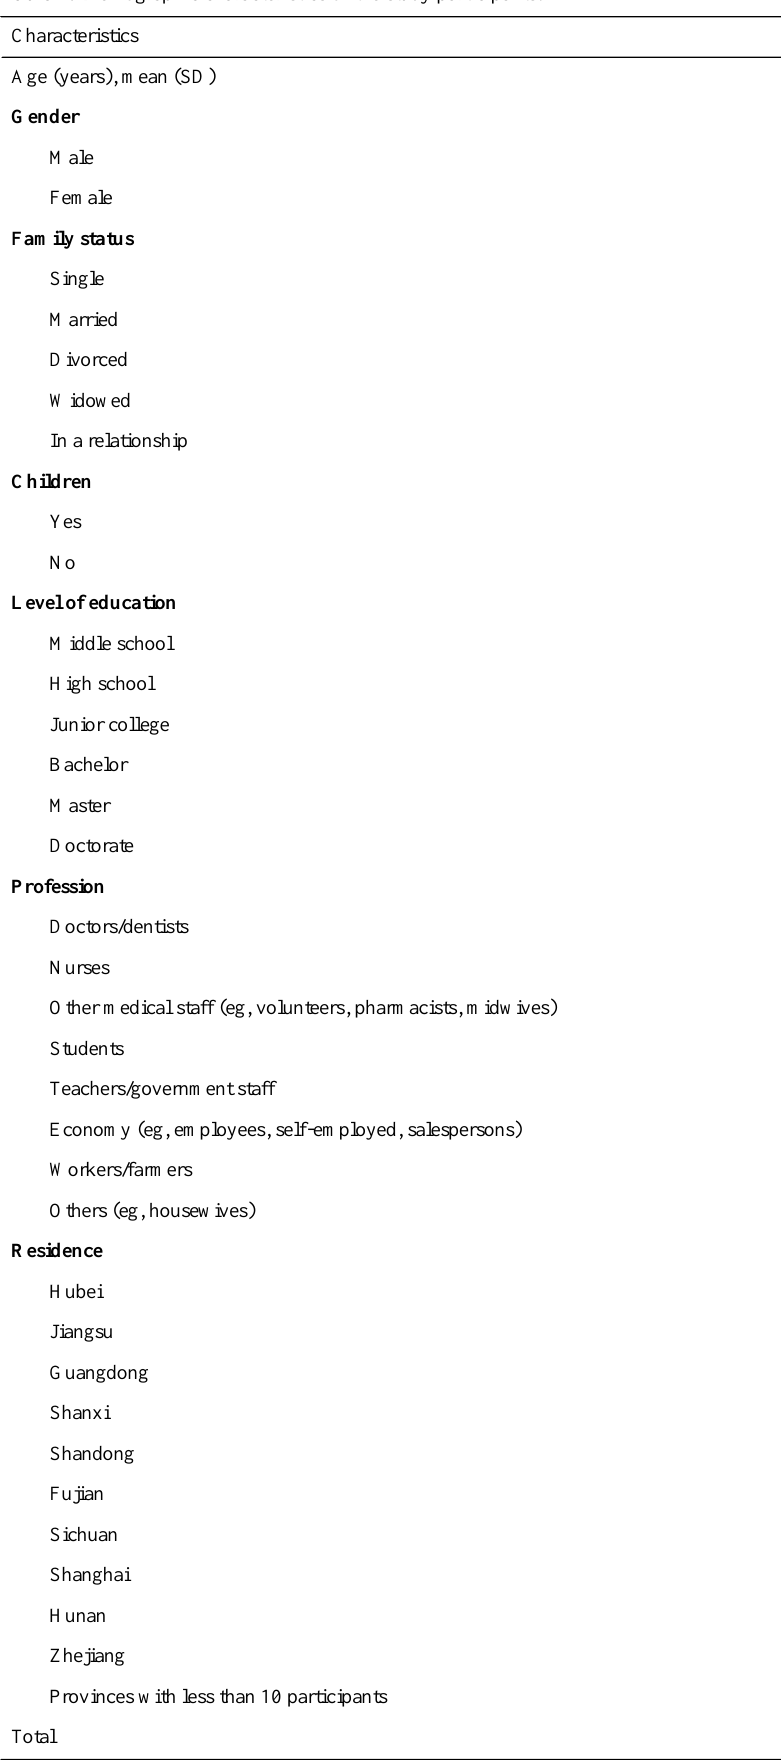
Table 1. Demographic characteristics of the study